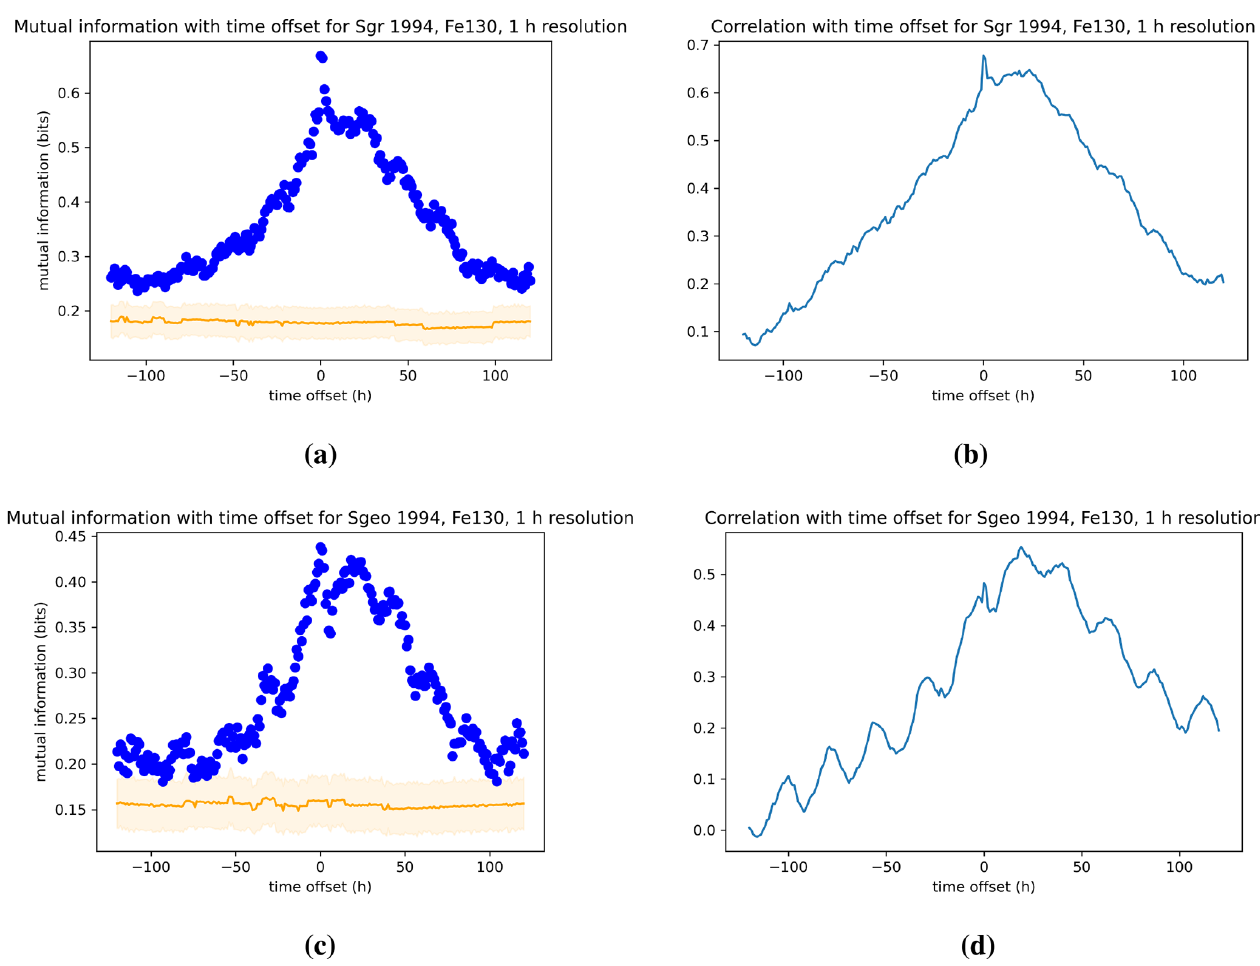
Figure 8. Dependence of the mutual information and Pearson correlation for ground (a, b) and geosynchronous (c, d) ULF power on the 130keV electron index F e 130 for the 1994 event. The data for both indices are processed with 1h